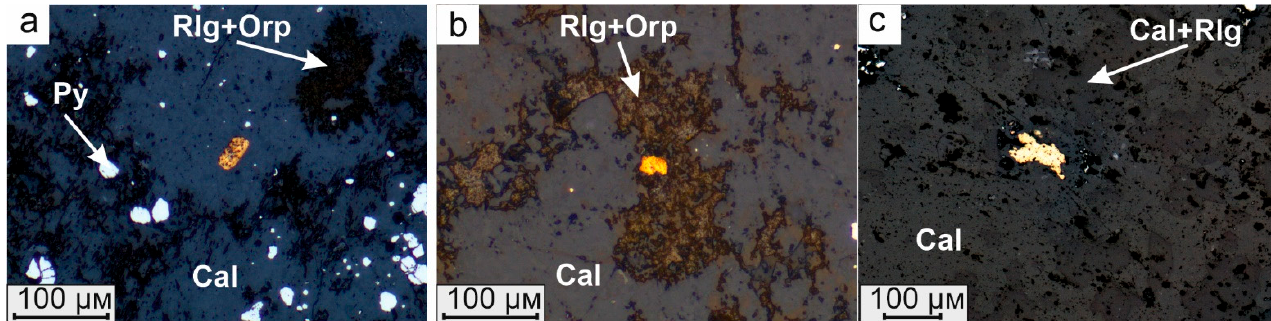
Figure 7. Optical photo of the native gold in realgar-orpiment breccias of the Vorontsovskoe deposit: ( a ) gold grain and pyrite (Py) in calcite; ( b ) the grain of gold in realgar-orpiment (Rlg + Orp) breccia cement; ( c ) gold in brecciated calcite marble; Cal + Rlg—the fine-crystalline calcite and realgar.